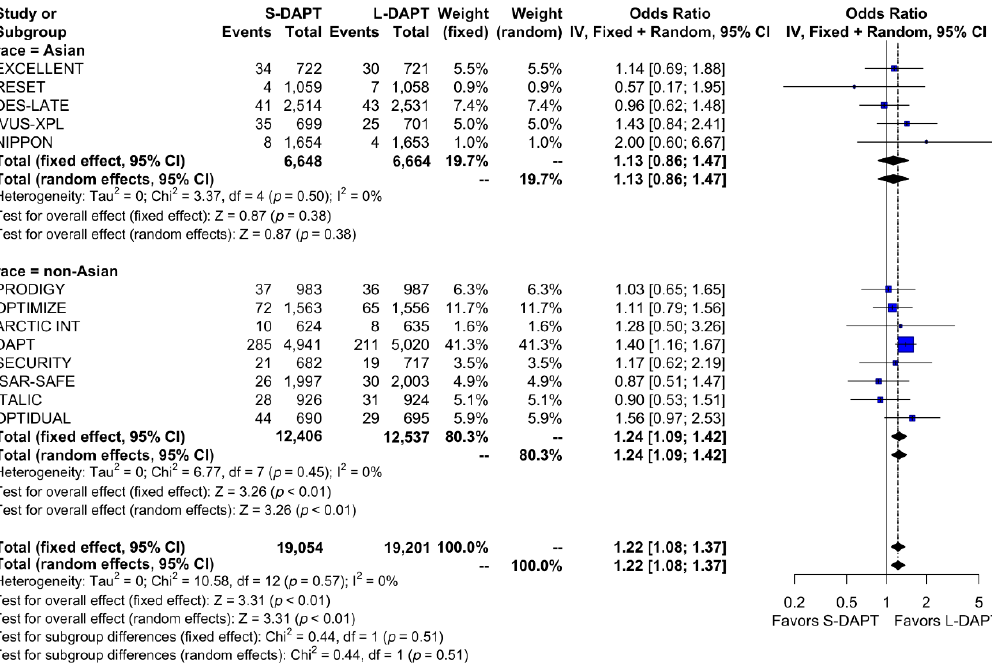
Figure 3. Ischemic outcomes in randomized clinical trials. S-DAPT, short duration dual antiplatelet therapy; L-DAPT, long duration dual antiplatelet therapy; CI, confidence interval.